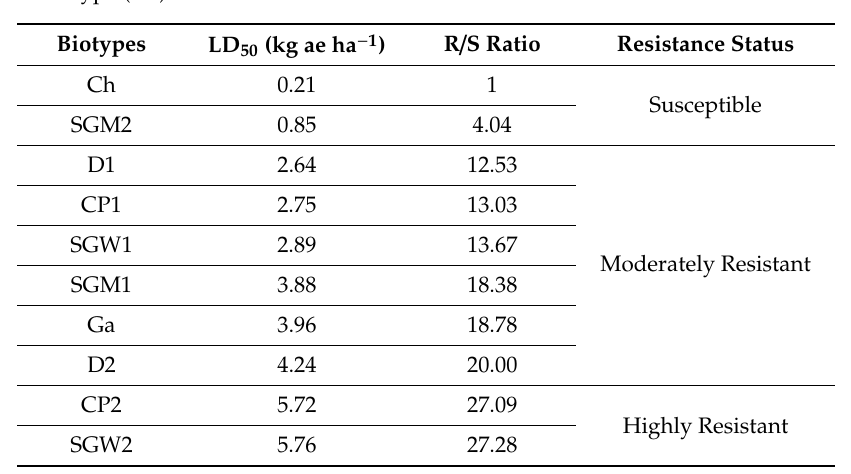
Table 4. Herbicide dose to kill 50% of plants (LD 50 , kg ae ha − 1 ) obtained to determine glyphosate resistance levels. Resistance / susceptible (R / S) is a ratio of LD 50 of each biotype compared to the most susceptible biotype